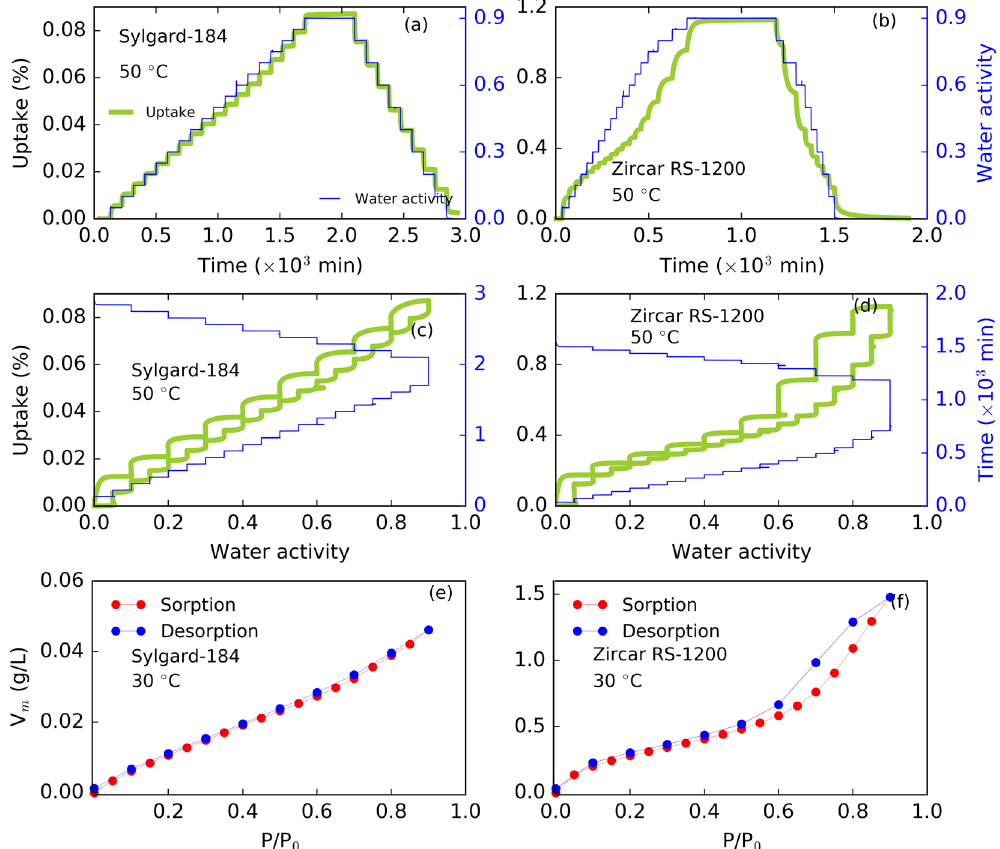
Figure 6. Experimental data from sorption and outgassing at 50 °C, and water vapor sorption and desorption isotherms at 30 °C in Sylgard-184 and Zircar RS-1200. Panel a and b: uptake % as a function of time (in mins) (and water activity in right y-axis) for Sylgard-184 and and Zircar RS-1200. panel c and d: uptake % as a function of water activity (and time in right y-axis) for Sylgard-184 and Zircar RS-1200. Panel e and f: water vapor sorption and desorption isotherms in Sylgard-184 and Zircar RS-1200 at 30 °C. The water vapor activity step is 0.05 in the sorption region, whereas it is 0.1 in the desorption region. Sylgard-184 does not show a hysteresis, whereas Zircar RS-1200 shows a hysteresis between sorption and